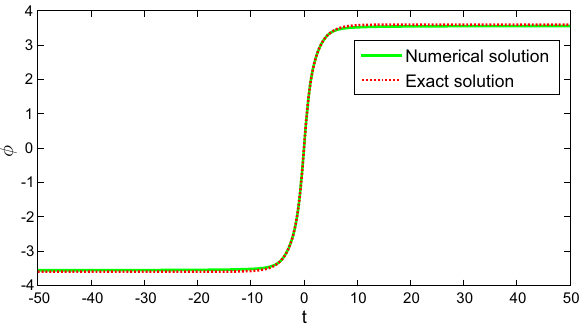
Fig. 9 Plot of φ as a function of time obtained numerically from Eq. (38) using the fitted expression for V given by Eq. (37), as well as from the exact solution of Eq. (7), for the parameter values c = 0 . 5 and s = 1